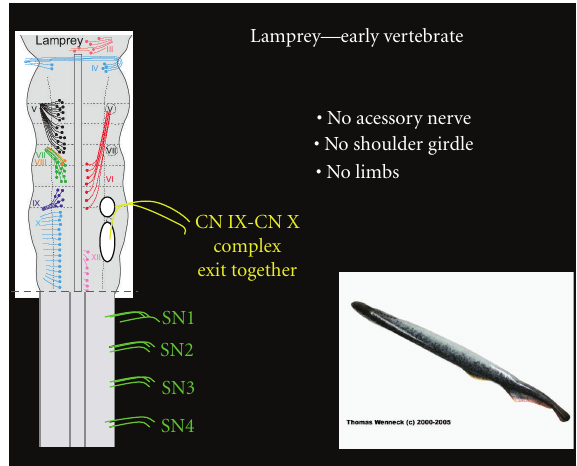
Figure 5: The lamprey lacks an accessory nerve, but has a glossopharyngeal and vagus root that are closely associated.